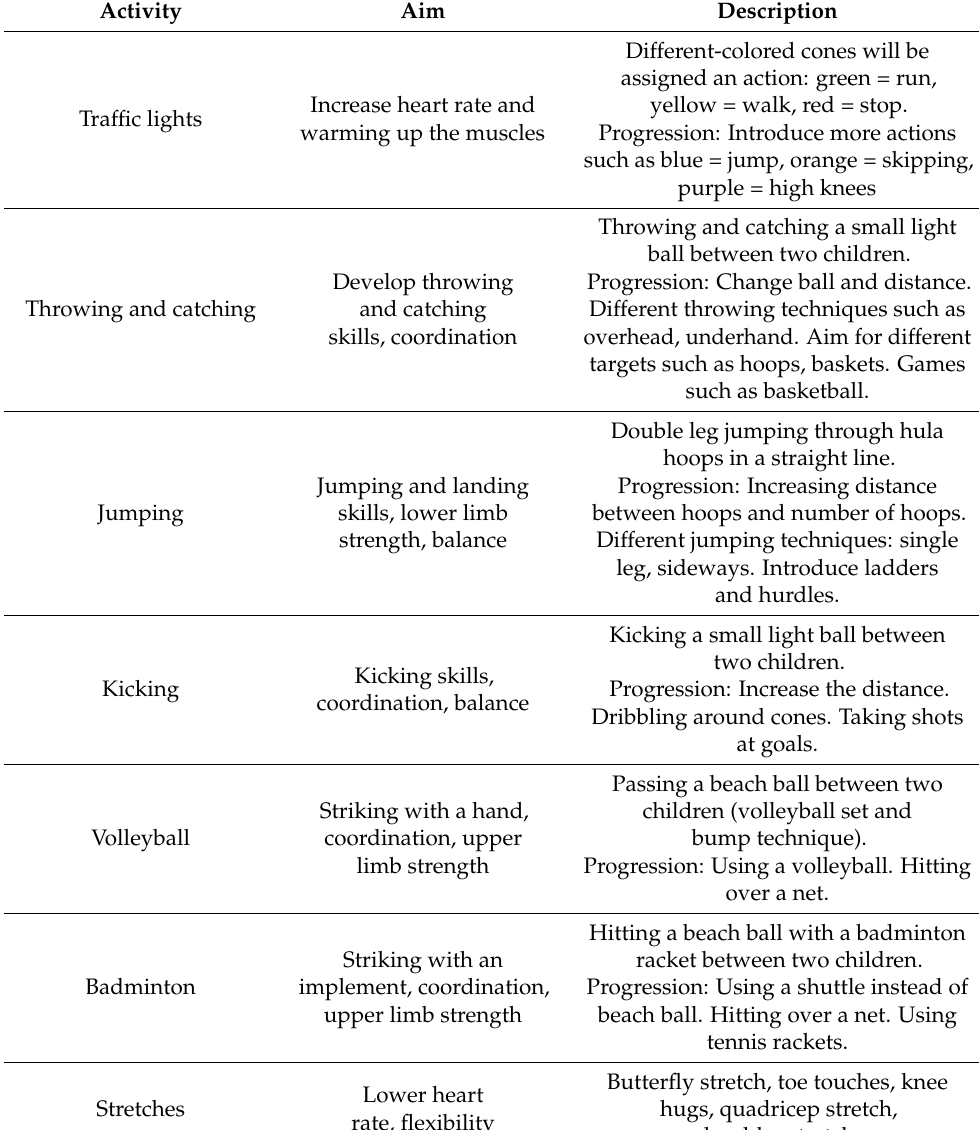
Table 1. Sample of activities in the exercise